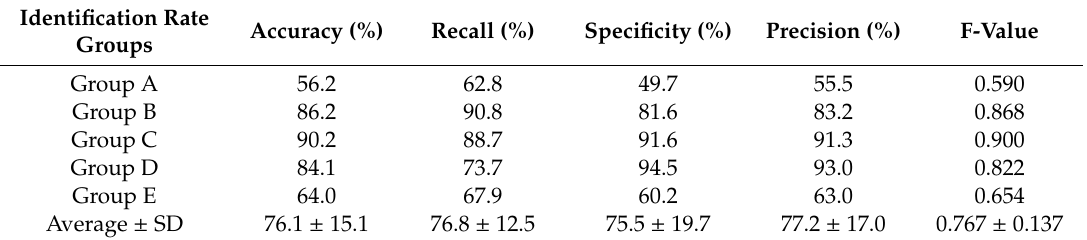
Table 5. Identification rate of the neural network based on deoxy image data.